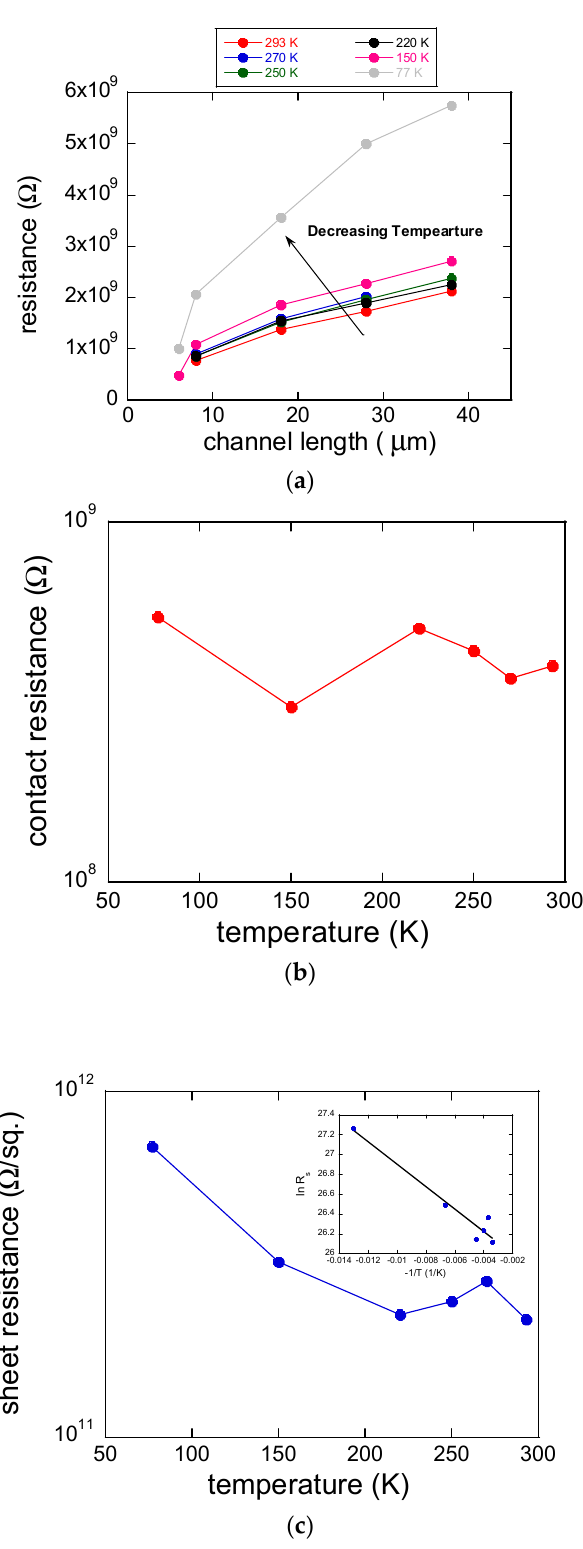
Figure 3. ( a ) Plot of total resistance as a function of channel length (6, 8, 18, 28, and 38 μ m) at different temperature ranging between 77 and 293 K. ( b ) Plot of ZnO/PbSe QD contact resistance as a function of temperature. ( c ) Plot of channel sheet resistance as a function of temperature. The inset shows a plot of ln R s vs. − 1 /T to calculate thermal activation energy based on Arrhenius equation. From the results of the contact and channel sheet resistance measurements, it is found that two consecutive processes govern the charge transfer rate at the ZnO/PbSe contact, as described in